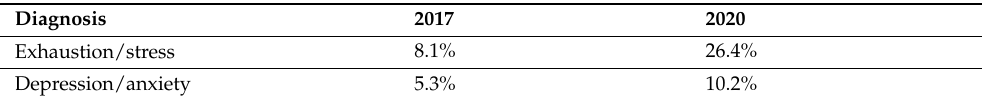
Table 1. Percentage of nurses diagnosed with exhaustion/stress and/or depression/anxiety in 2017 and